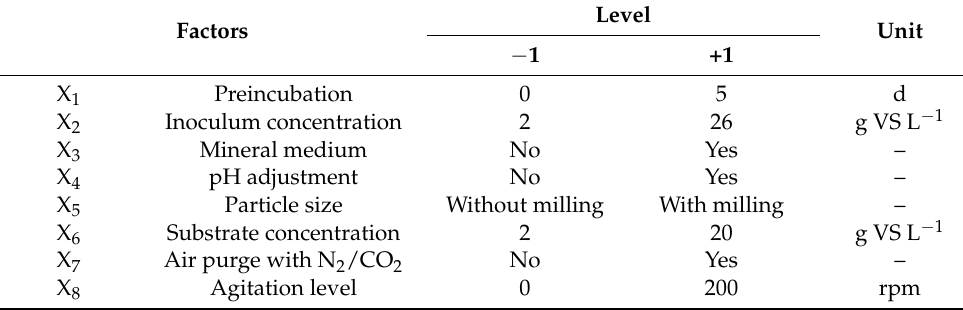
Table 2. Factors and levels evaluated for the Plackett–Burman